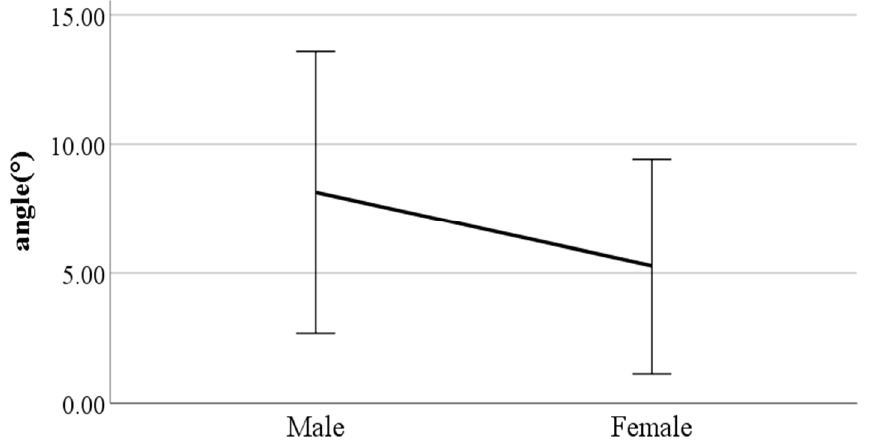
Figure 12. Gender difference in the flexion of the spinal column in the sagittal plane at heel-strike (F value: 11.29, DF: 289, p -value: 0.00).